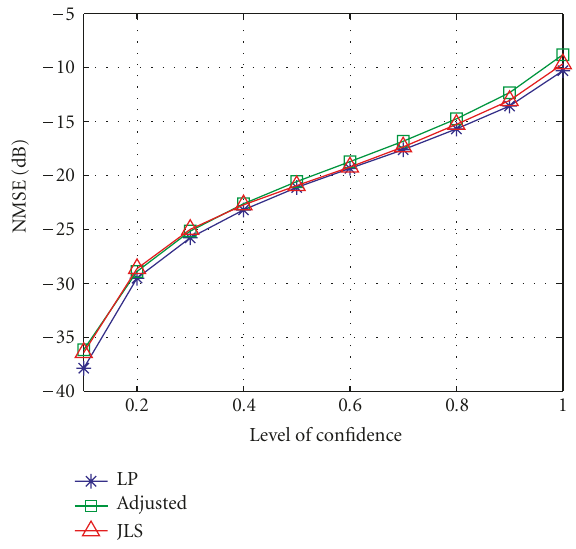
Figure 9: Performance evaluation of LMMSE prediction methods in a suburban area. Figure 10: NMSE versus level of confidence (urban area).